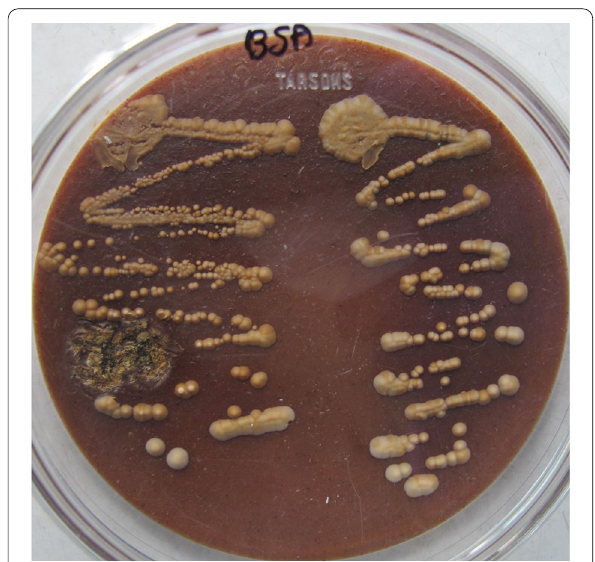
Fig. 2 Brown-coloured mucoid colonies of Cryptococcus neoformans on Bird Seed Agar (BSA)